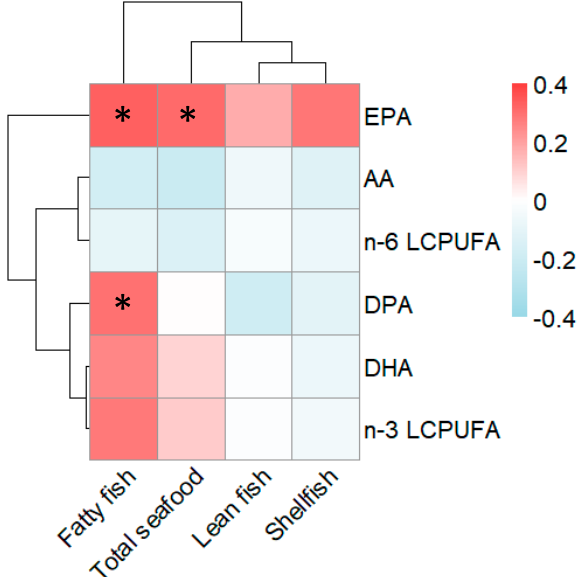
Figure 1. Heatmap of the correlations between reported maternal seafood intake during pregnancy and proportions of fatty acids in cord serum. The magnitude of each correlation is denoted with a color, whereby the red color indicates a positive correlation and the blue color represents a negative correlation. A darker shade of each color indicates a stronger correlation. Statistical significance using Spearman correlations is denoted by an asterisk ( p < 0.05). AA, Arachidonic acid; EPA, eicosapentaenoic acid; DPA, docosapentaenoic acid; DHA, docosahexaenoic acid; LCPUFA, long-chain polyunsaturated fatty acid.